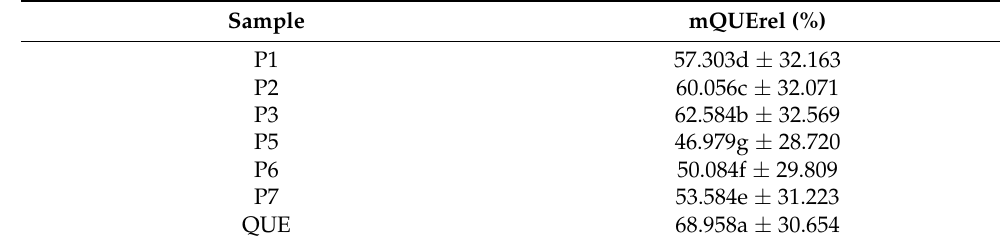
Figure 9. Interval plots of the percentage of QUE released (mQUErel (%)) from the microspheres for Sample * Time interaction factor levels. Table 4. Percentage of QUE released (mQUErel (%)) from the microspheres as a function of the Sample factor levels.